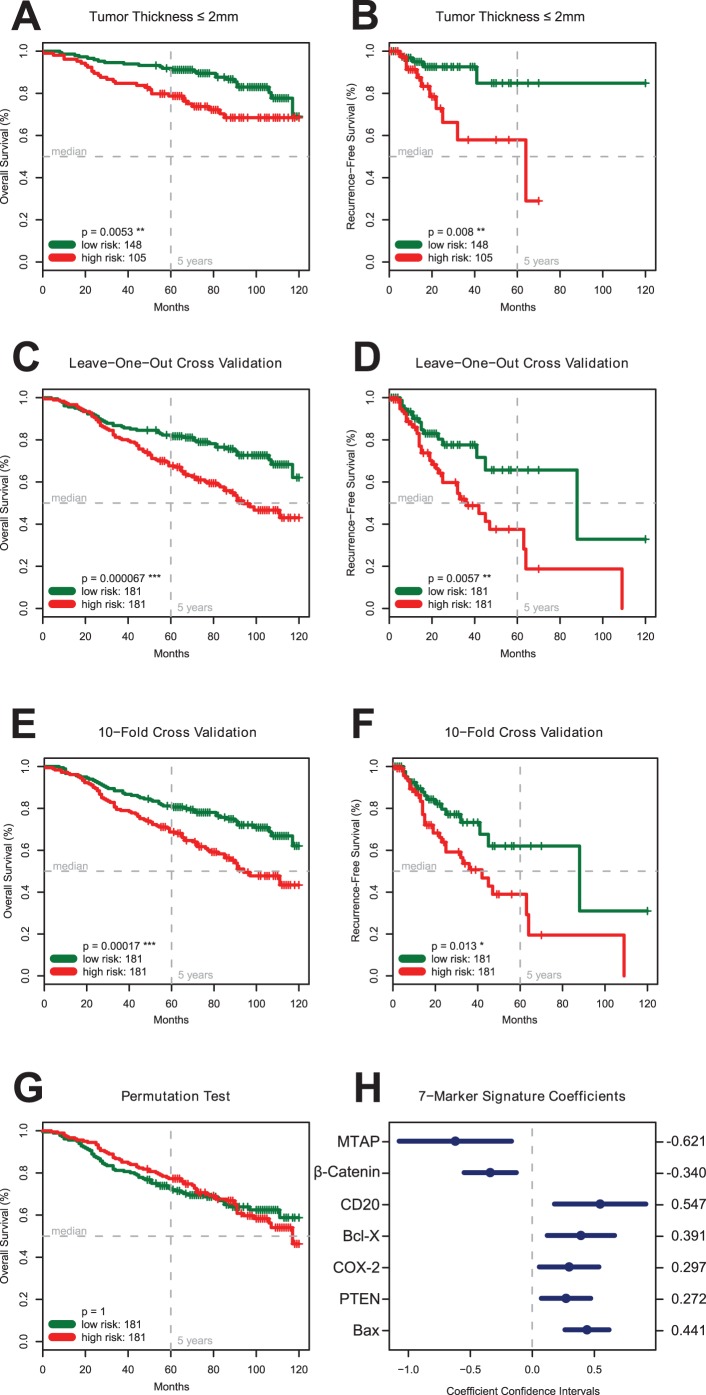
Statistical Analyses. Panel A, B. The Seven-Marker Signature and Survival of Patients with a Tumor Thickness ≤2.0 mm (TMA 1).Kaplan-Meier estimates show a significantly lower overall (p<0.01, Panel A) and recurrence-free survival (p<0.01, Panel B) for patients with a comparatively low tumor thickness ≤2.0 mm but high-risk score. Panel C, D. Leave-One-Out Cross Validation. To investigate the generalization error of the models produced by the FDR signature learning procedure a leave-one-out cross validation experiment was conducted on the primary cohort of 362 MM patients. The resulting risk score could significantly (p<0.001) differentiate between patients with higher or lower overall survival expectance. The two patient groups also significantly (p<0.01) differ in recurrence-free survival. Panel E, F. 10-Fold Cross Validation. In addition, the FDR marker selection procedure was tested by a 10-fold cross validation experiment on the 362 patients of the primary cohort (TMA 1) resulting in still significant estimates for overall survival (p<0.001; Panel E) and recurrence-free survival (p<0.05; Panel F). Panel G. Permutation Test. In addition to the cross validation experiments a permutation test was conducted to assess if the signature learning procedure is over fitting the data set. The resulting signature, which was learned on permuted overall survival data, was not able (p = 1) to discriminate between patients with differing survival expectance. This result indicates that the proposed learning procedure does not over fit the data. Panel H. Coefficients and Confidence Intervals of the Seven-Marker Signature. The coefficients from the univariate Cox proportional hazard models are used in a weighted linear combination to predict the risk score for each patient. Markers with negative coefficients represent protective markers (MTAP, β-Catenin); those with positive coefficients risk markers (Bax, Bcl-X, PTEN, COX-2, and presence of CD20 positive lymphocytes,).